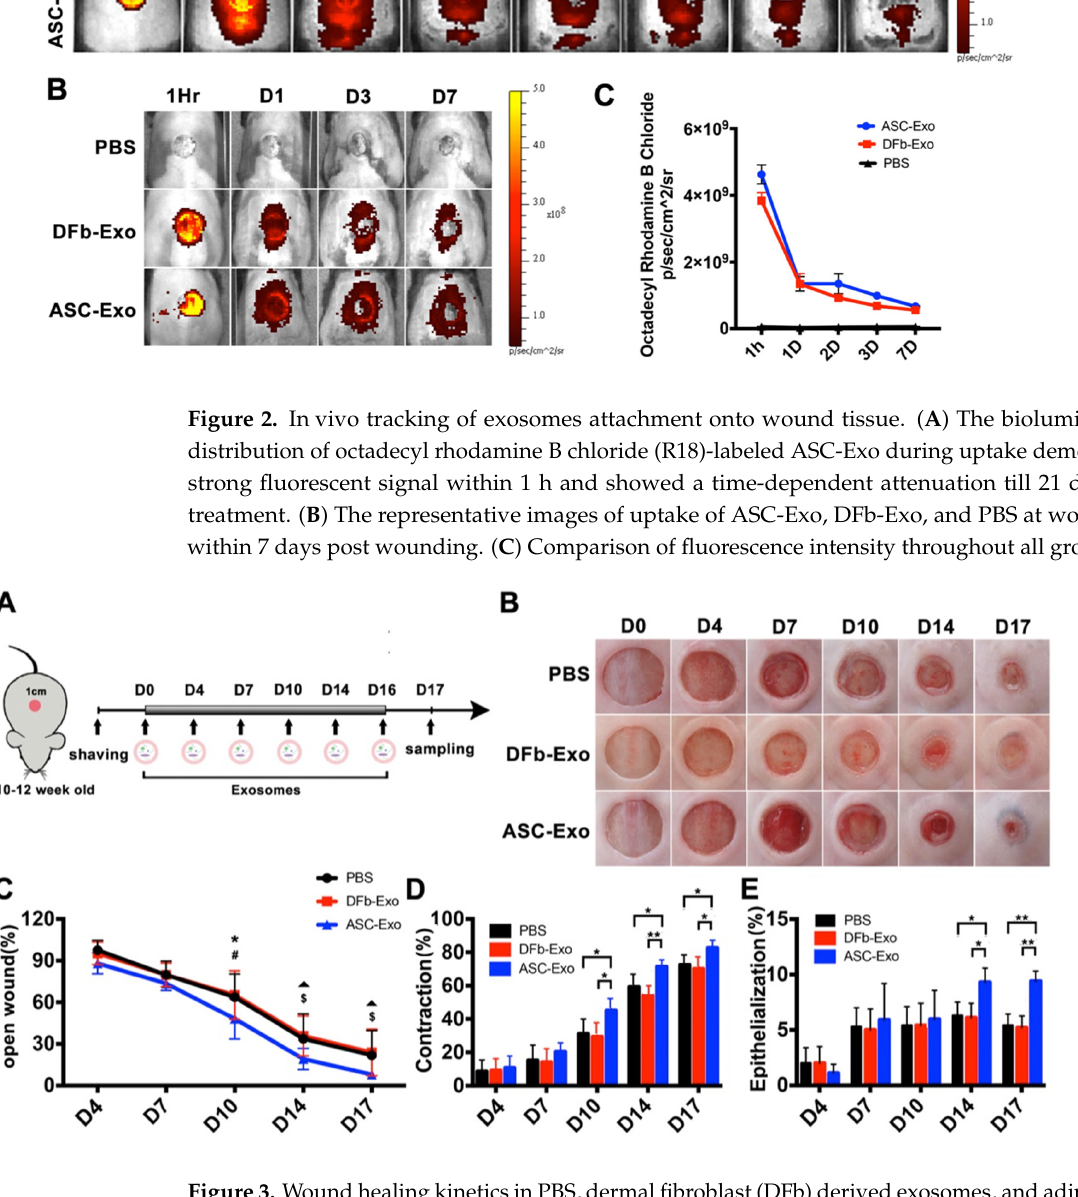
Figure 2. In vivo tracking of exosomes attachment onto wound tissue. ( A ) The bioluminescence dis- tribution of octadecyl rhodamine B chloride (R18)-labeled ASC-Exo during uptake demonstrated strong fluorescent signal within 1 h and showed a time-dependent attenuation till 21 days after treatment. ( B ) The representative images of uptake of ASC-Exo, DFb-Exo, and PBS at wound sites within 7 days post wounding. ( C ) Comparison of fluorescence intensity throughout all groups.